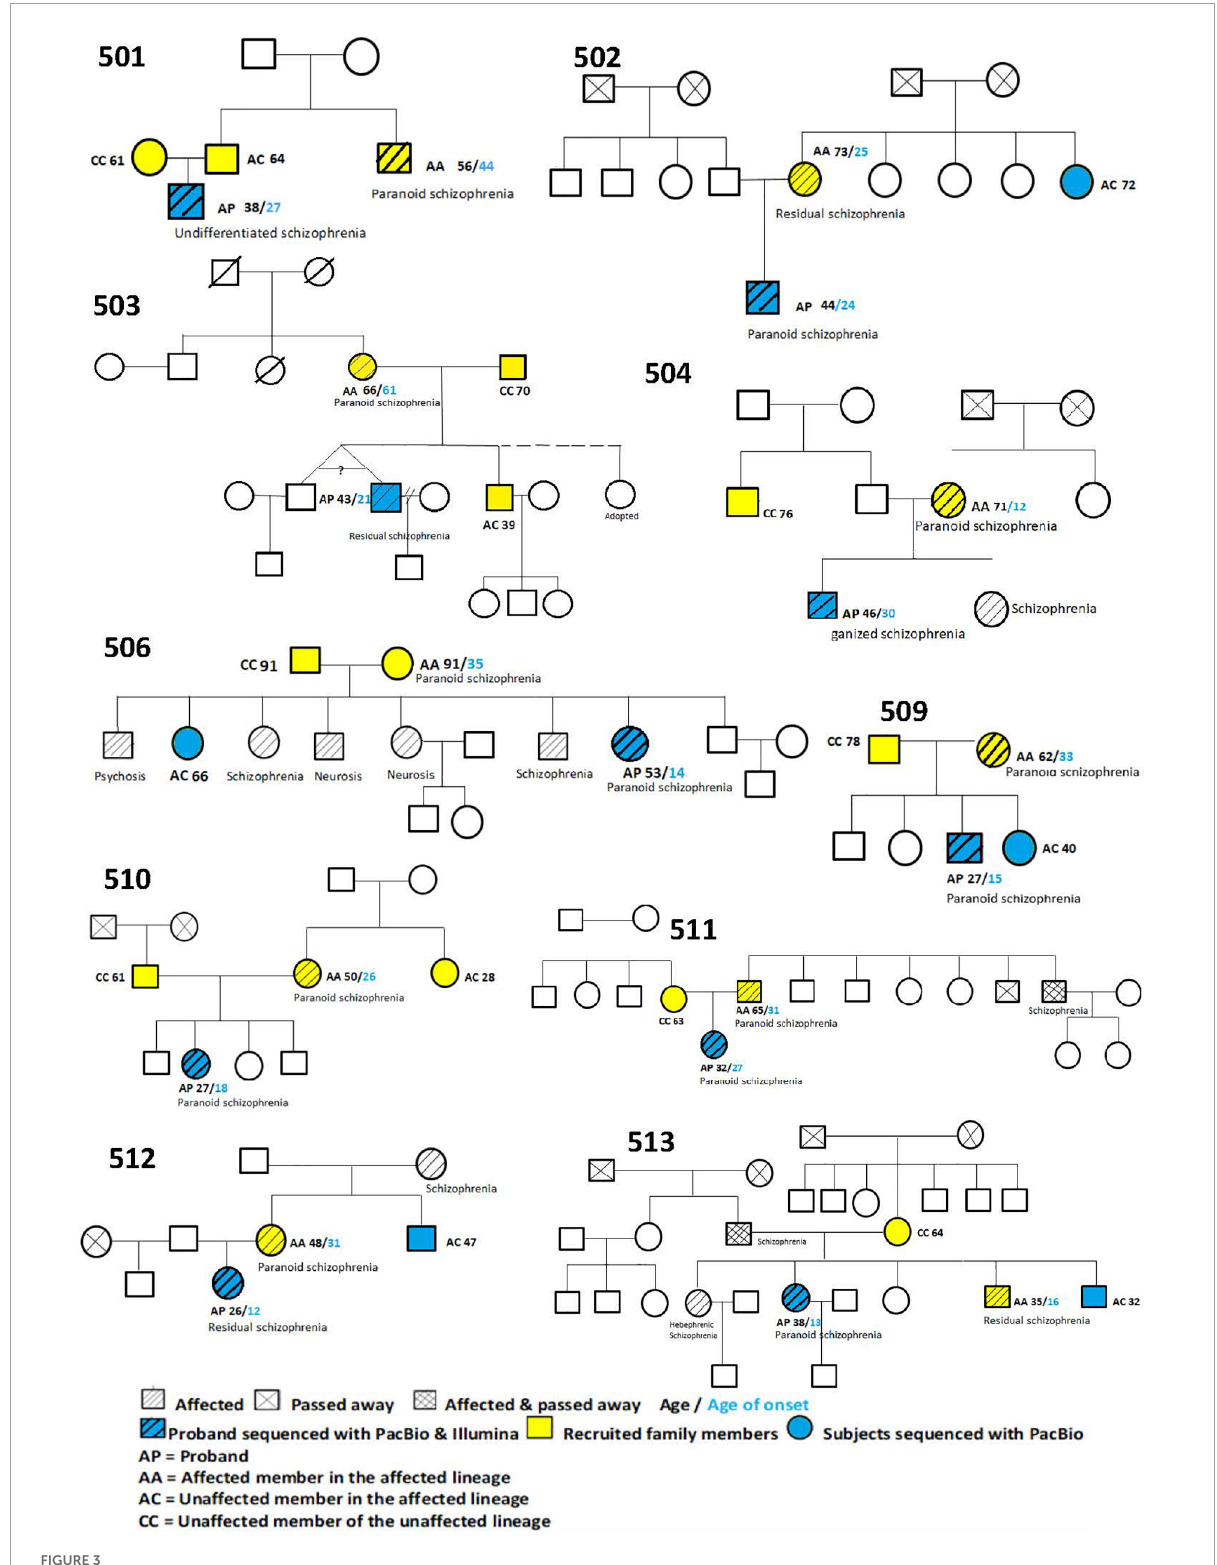
FIGURE3 Pedigree tree of 10